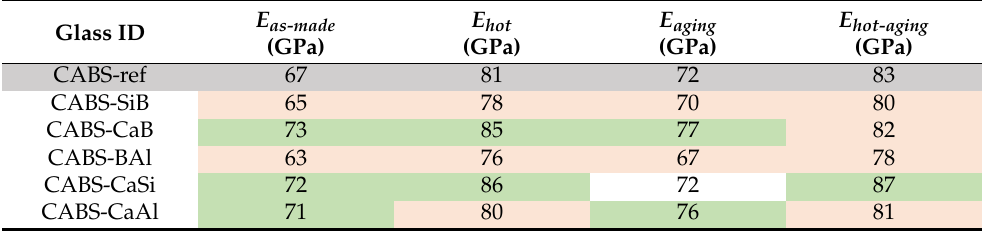
Young’s moduli ( E ) of the as-made, hot-compressed, humid-aged, and hot- compressed/humid-aged CABS glasses. Coloring indicates Young’s moduli of reference glass (grey), increasing Young’s moduli relative to reference (green), and decreasing Young’s moduli relative to reference (red). The error was within ± 2